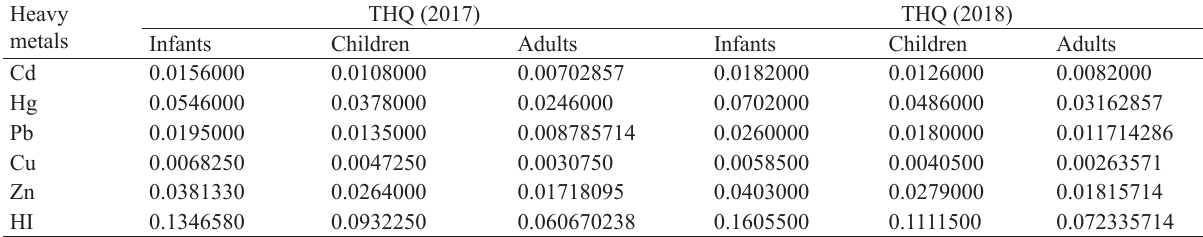
Table 3 Target hazard quotients (THQ) and hazard index (HI) of elements consumed with Merlangius merlangus L. caught near the southern coast of the Black Sea in 2017 and 2018 Heavy